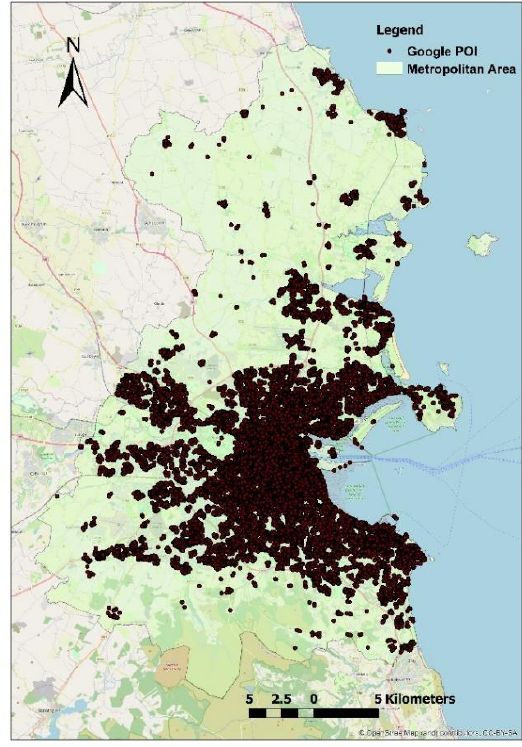
Figure 1: Geographical distribution of Google POI in